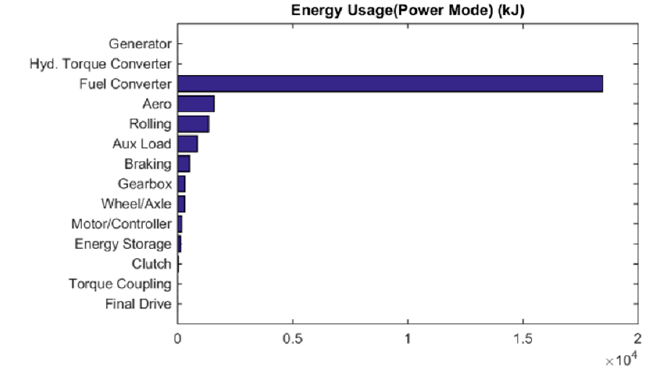
Figure 21. Motor torque-speed.